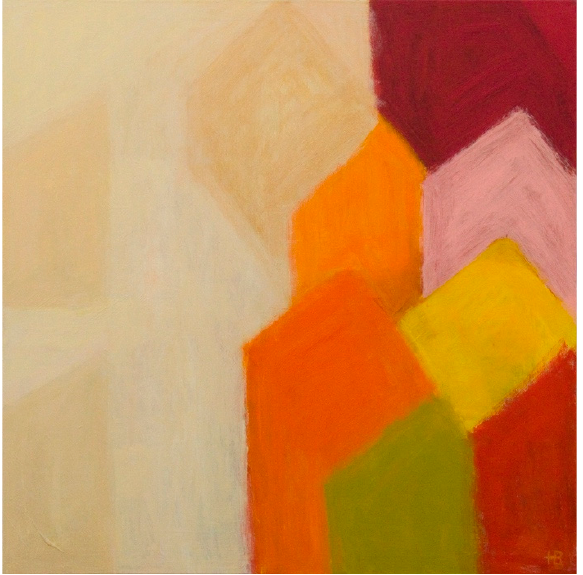
Figure 4. Hannah Bischof, “ Zwischenzeit ”, acrylic on canvas, Berlin 2015, © Ben Bischof.